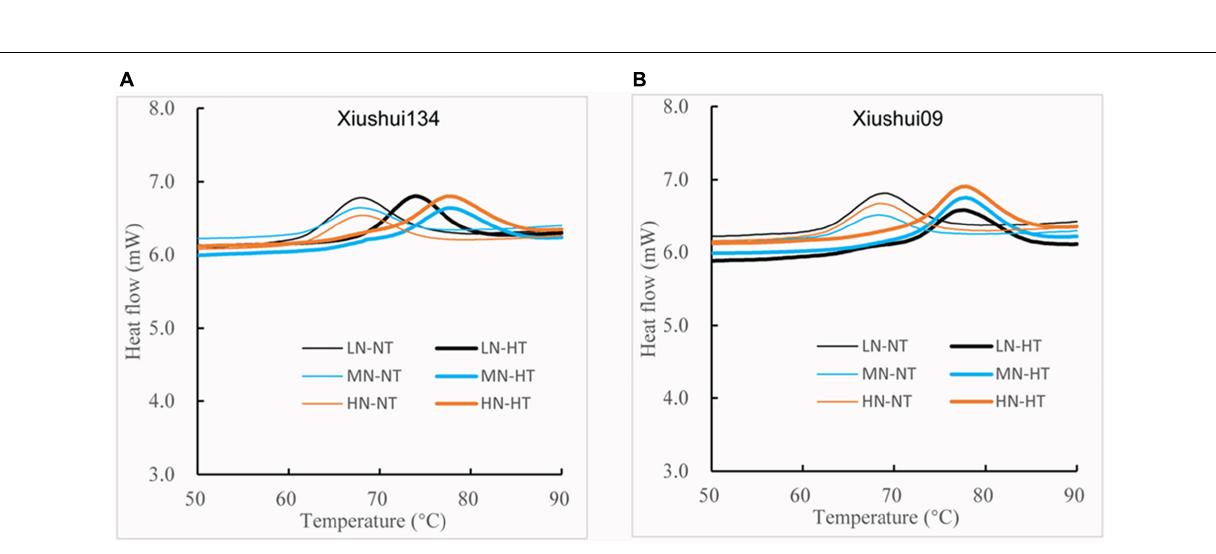
Frontiers in Plant Science |